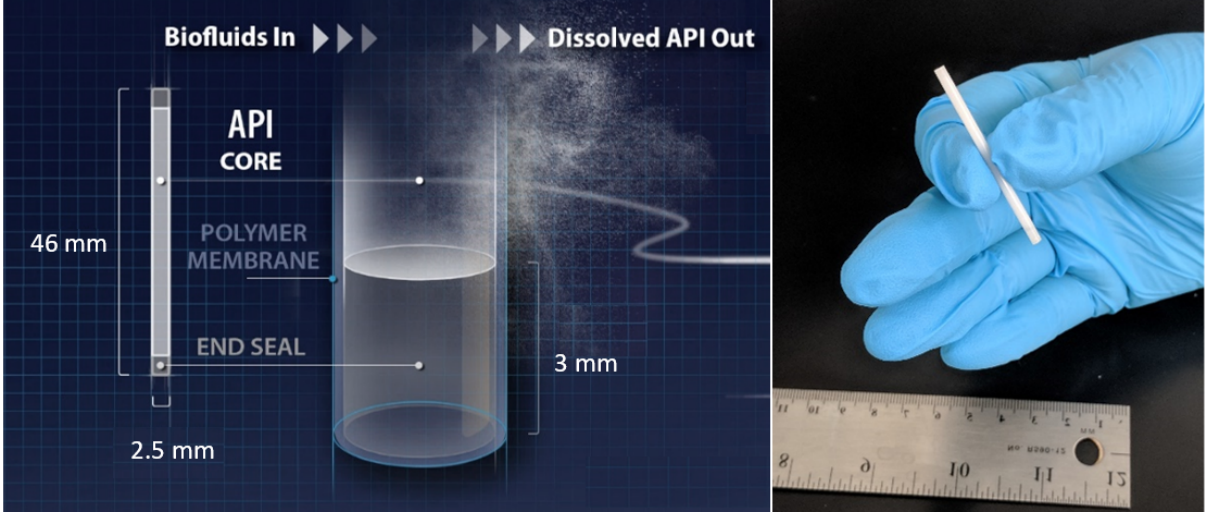
Figure 1. ( Left ) A schematic of a PCL reservoir-style implant for delivery of TAF. All implants were 2.5 mm in outer diameter (OD) and 46 mm in total implant length with a 40 mm paste and two 3 mm PCL end seals. ( Right ) A digital camera image of the biodegradable implant.